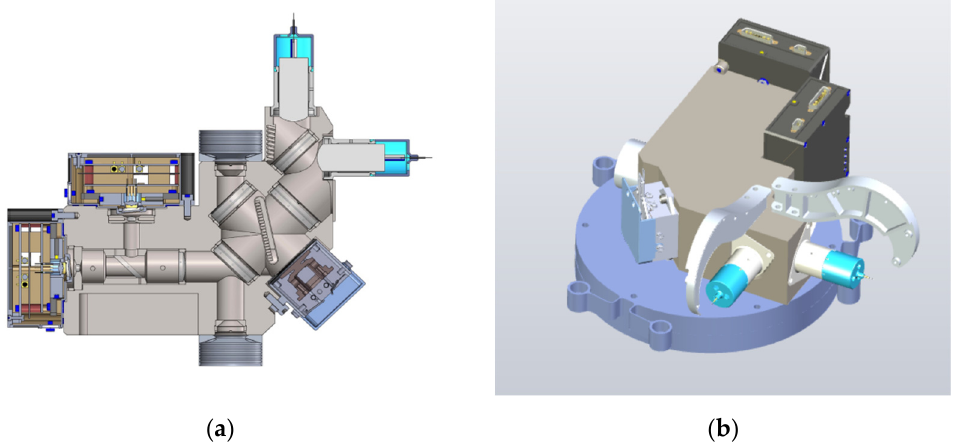
Figure 9. Optical bench concept for NGGM. ( a ) Cross-sectional view of the optical bench; ( b ) CAD picture of optical bench body with attached collimators, steering mirror and quadrant photoreceivers.